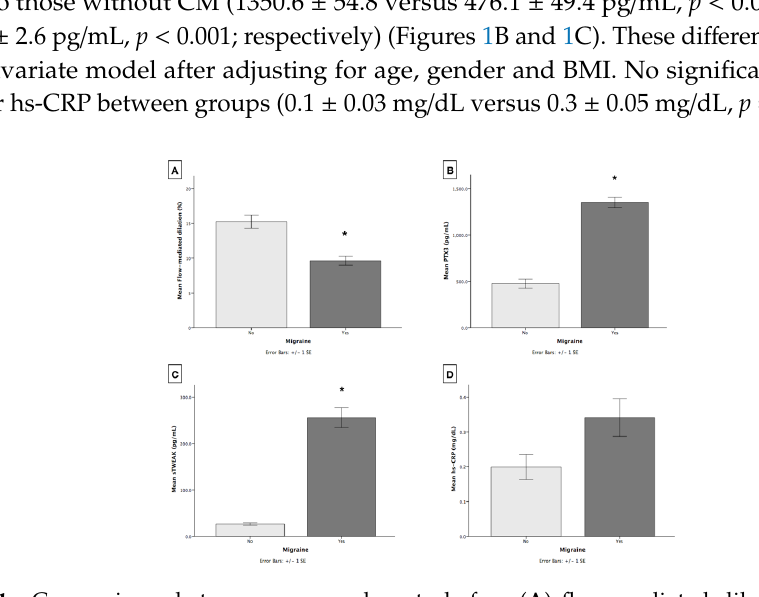
Figure 1. Comparisons between cases and controls for: ( A ) flow-mediated dilation (FMD) (%); ( B ) Serum levels of Pentraxin 3 (PTX3) (pg / mL); ( C ) Serum levels of soluble tumour necrosis factor-like weak inducer of apoptosis (sTWEAK) (pg / mL); ( D ) Serum levels of high sensitivity C-reactive protein hs-CRP (mg / dL). * p <